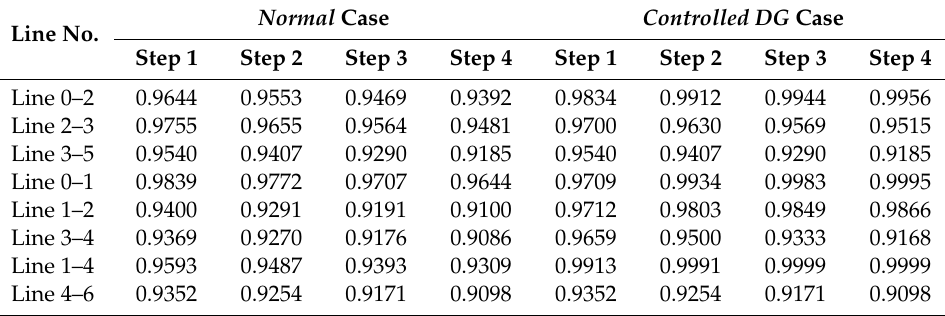
Table A9. Receiving cos( ϕ ) values of lines for all steps and both cases. Line